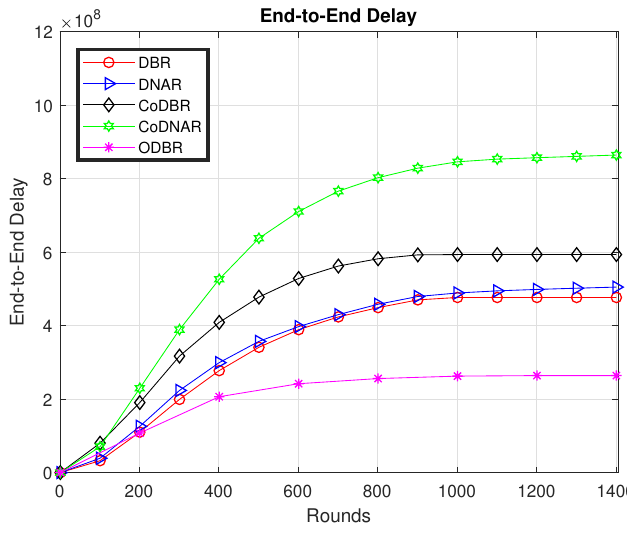
Figure 15. Average end-to-end